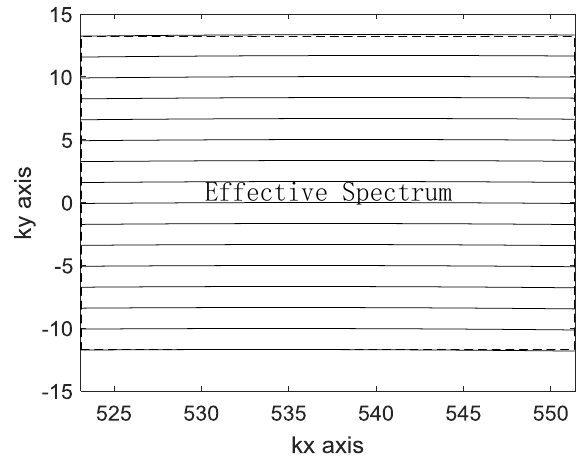
Figure 7. Spectrum of proposed interpolation.